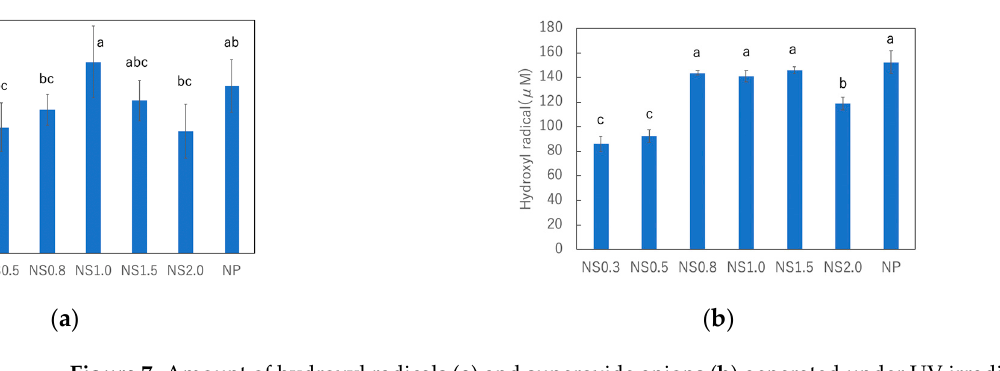
Figure 7. Amount of hydroxyl radicals ( a ) and superoxide anions ( b ) generated under UV irradiation by titania nanosheets and nanoparticles. The same letters are not significantly different at α = 0.05.